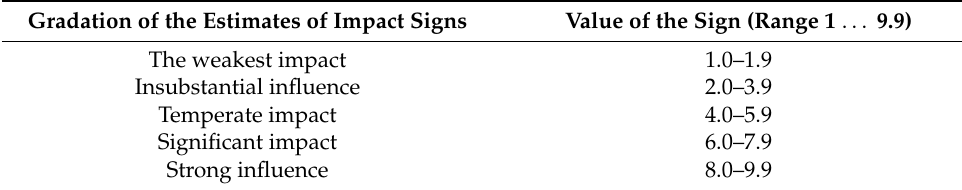
Table 4. Gradation of the qualitative estimates of the signs of impact on setting the R&D product price 1